Question: Summarize what this figure shows in one sentence.
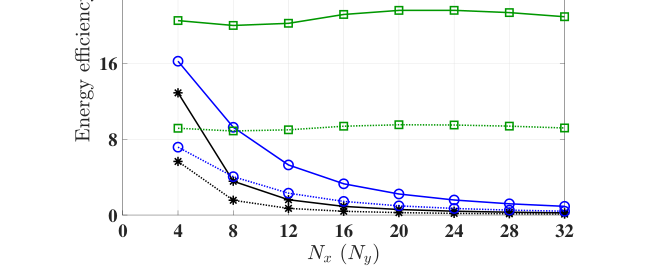
Answer: Comparison of the energy efficiency versus the number of RHS elements for various beamforming schemes.